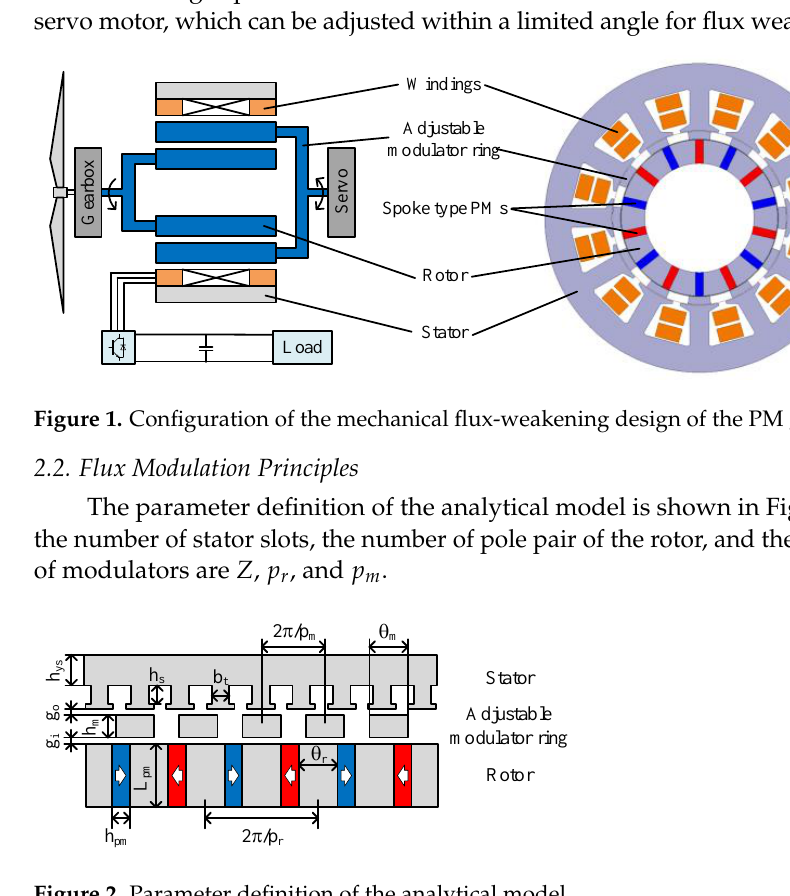
Figure 2. Parameter definition of the analytical model.